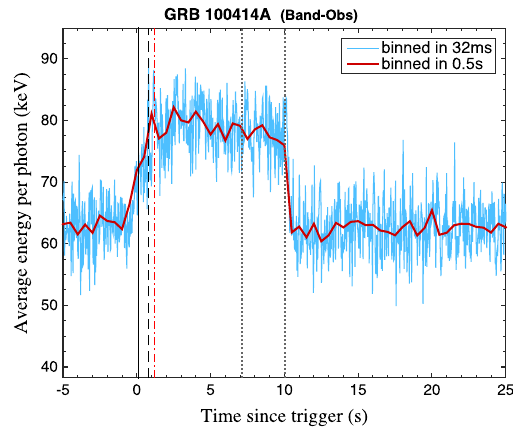
energy curve). The vertical dash-dotted line (red) refers to t obs /( 1 + z ) of Criterion 3 and the dotted lines refer to other peaks in the light curve